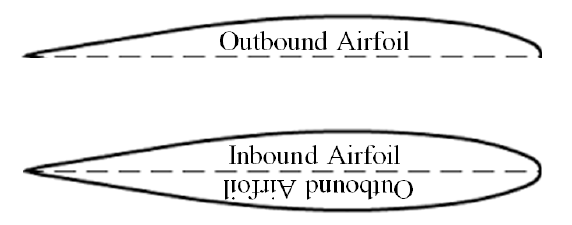
Figure 2. Schematic airfoil configuration at the glider ( top ) and aerobatic phases ( bottom ).